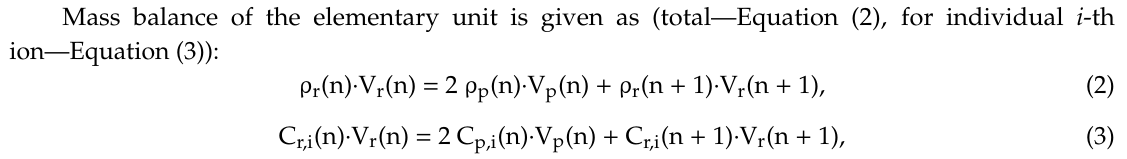
Figure 1. Scheme of an elementary NF module unit.